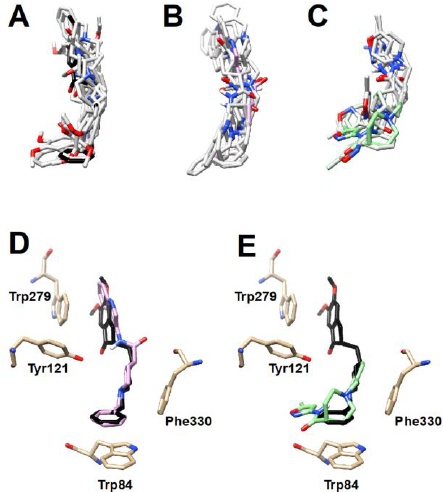
Figure 4. Computational binding of compounds at acetylcholinesterase (AChE). ( A – C ) represent the nine predicted conformations while ( D , E ) refer to the lowest energy binding orientations obtained by docking.